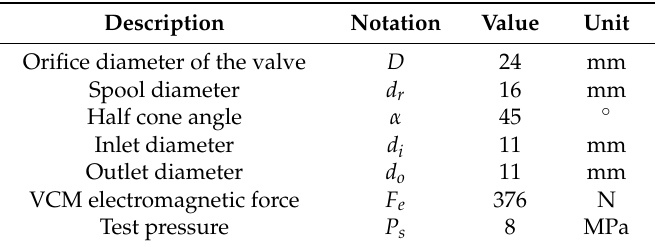
Figure 10. Pictures of VCM-DHPV prototype and test system: ( a ) VCM-DHPV prototype; and ( b ) test bench. Table 2. Parameters of the proposed VCM-DHPV